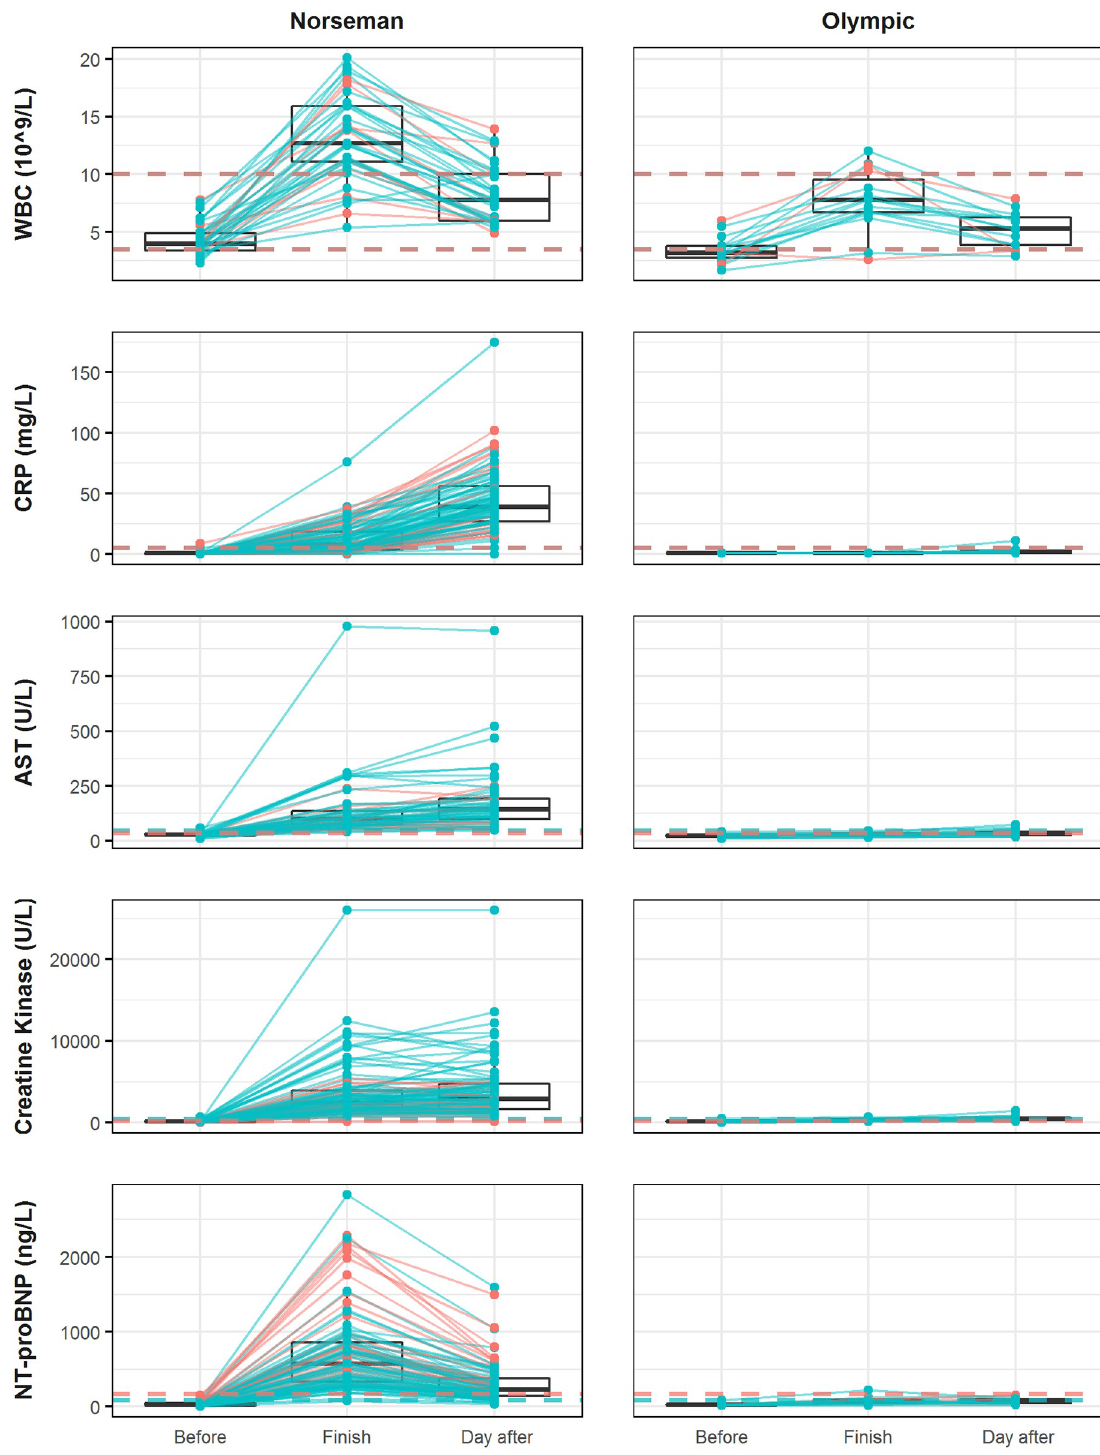
Fig 2. Individual values. Results for White blood cell count, CRP (C-reactive protein), AST (Aspartate Aminotransferase), Creatinine Kinase and NT-proBNP before the race, at the finish line and on the day after the Norseman (left) and Olympic (right) distances. Individual values are given with lines connecting each participant. Green points indicate male sex and red points indicate female sex. The green dotted line is a laboratory reference value for males; red is for females and brown indicates the same reference line for both sexes. The y-axis is identical for the Norseman and Olympic distances for each biochemical